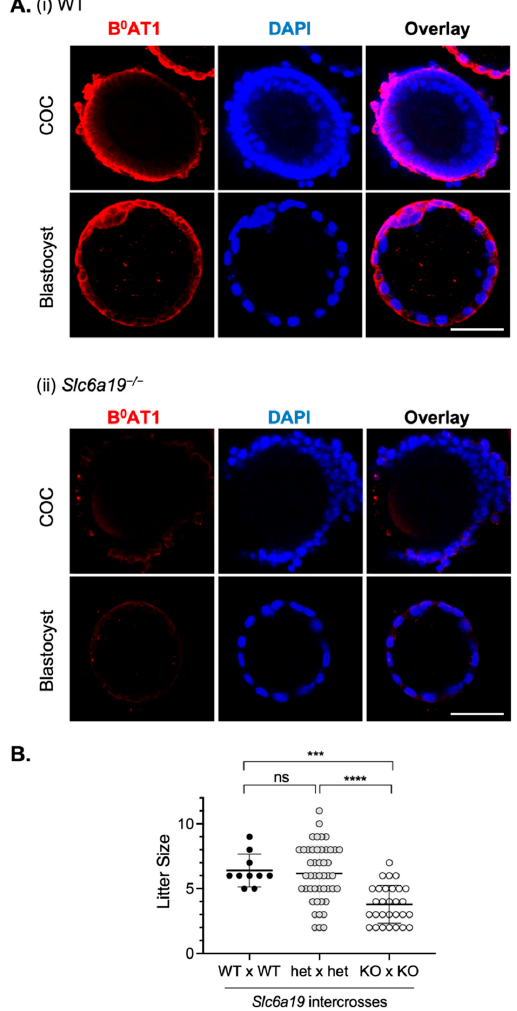
Figure 3. B 0 AT1 deficiency impairs mouse fertility. ( A ) COCs and blastocysts were freshly isolated from ( i ) WT and ( ii ) Slc6a19 − / − mice and immunostained for B 0 AT1 (red) and DAPI (blue) to confirm loss of B 0 AT1 protein in knockouts. Scale bar = 50 µ m for all images. No staining was observed when a pre-immune IgY was used as a negative control for B 0 AT1 staining (not shown). ( B ) The number of pups born from wild-type (WT × WT) [31], heterozygous (het × het) and homozygous Slc6a19 − / − mice (KO × KO) intercrosses. Data show mean ± SD; *** p < 0.001, **** p < 0.0001, ns is not